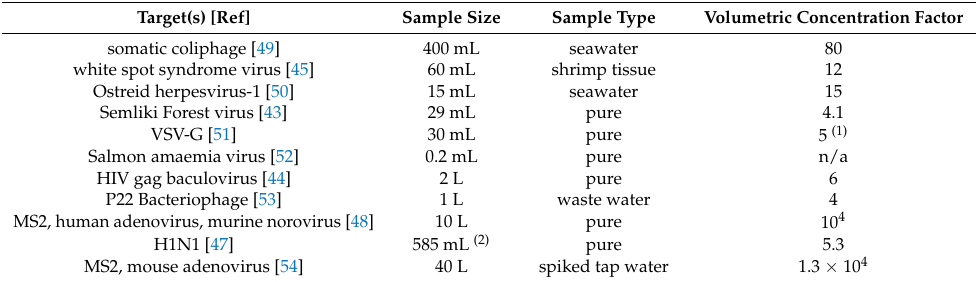
Table 2. Viral concentration methods via centrifugation and/or